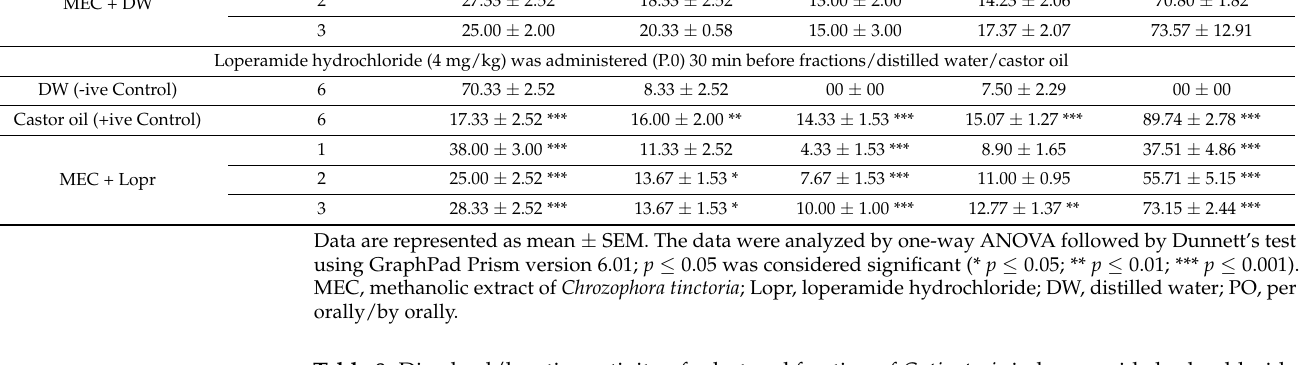
Table 8. Diarrheal/laxative activity of n-butanol fraction of C. tinctoria in loperamide hydrochloride in-duced constipation in